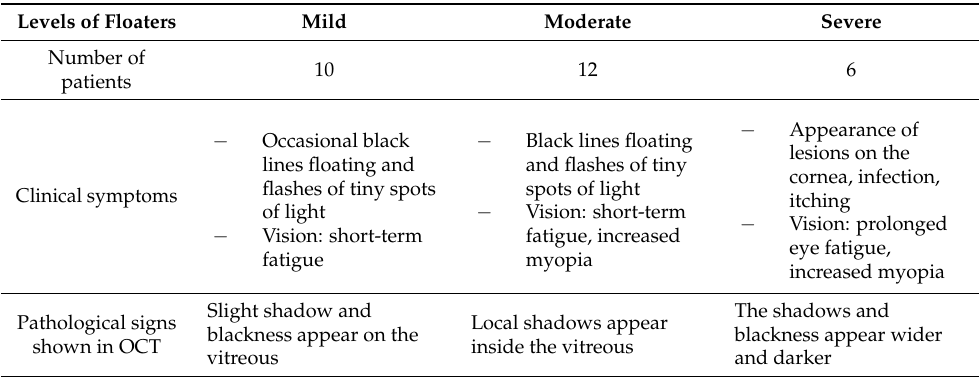
Figure 4. Measurement results of B-type ultrasound scanner. ( a – c ) Imaging analysis of mild, moderate, and severe floaters, respectively. The figure on the right is the OCT in the horizontal and vertical directions. Table 1. The clinical symptoms and pathological sign details are shown on OCT images for levels of vitreous